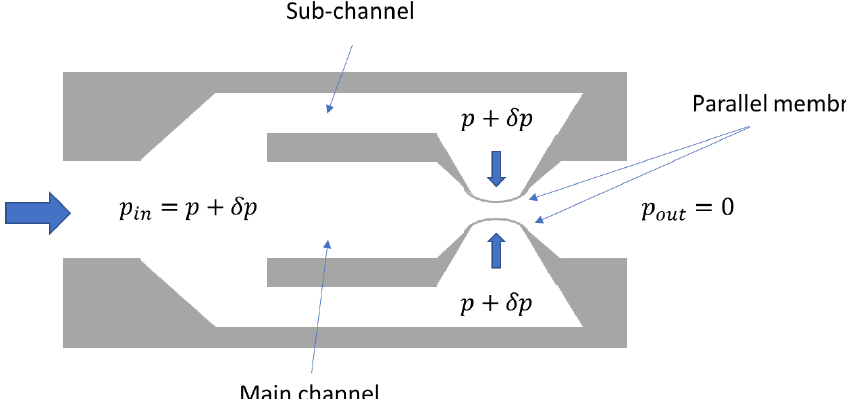
Figure 8. Schematic drawing of a passive flow regulator using autonomous deflection of parallel membrane valves. The increase δ p of the inlet pressure induces a deflection of two membranes and thus an increase δ R h of the hydraulic resistance of the device (adapted from Reference [42]).